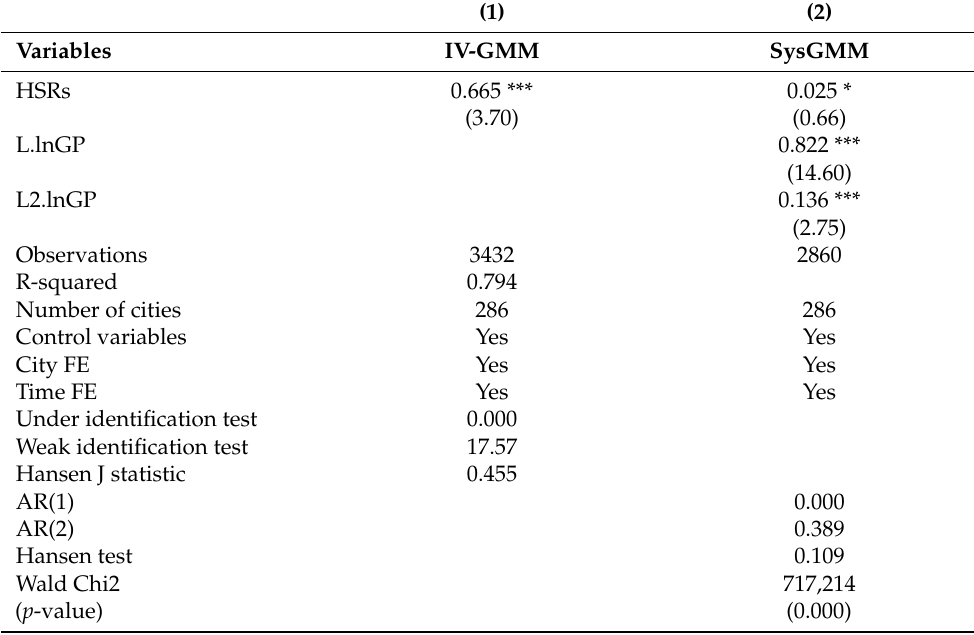
Table 3. Endogenous